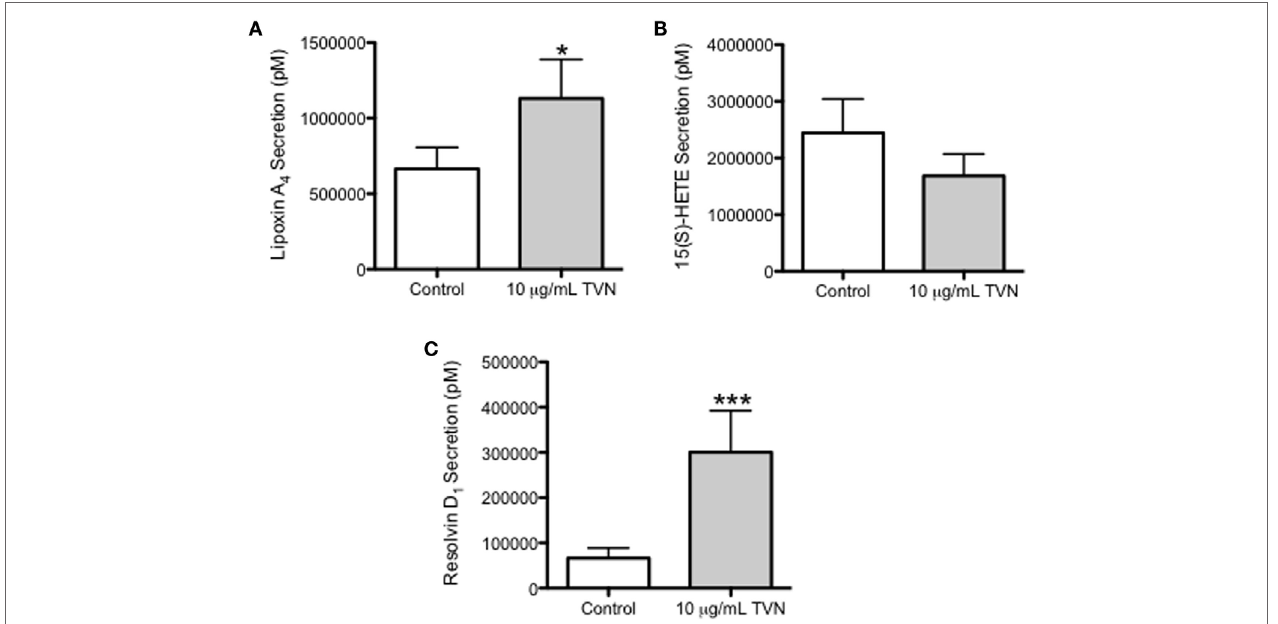
FigUre 7 | Tylvalosin promotes the secretion of the pro-resolution lipid mediators LXA 4 and RvD 1 . Secreted levels of LXA 4 (a) , its metabolite precursor 15(S)-HETE (B) , and RvD 1 (c) were measured from porcine neutrophils treated with 10% HI-FBS in HBSS (control) or with 10 μ g/mL tylvalosin for 0.5 h using liquid chromatography–mass spectrometry (LC/MS). Values represent mediator levels in pM calculated from standard curves generated by integrating the area under the curve of elution peaks where intensity correlated with known LXA 4 , 15(S)-HETE, or RvD 1 concentrations, respectively. Data represent mean ± SEM ( n = 18–20). * P < 0.05, *** P < 0.01 versus unstimulated